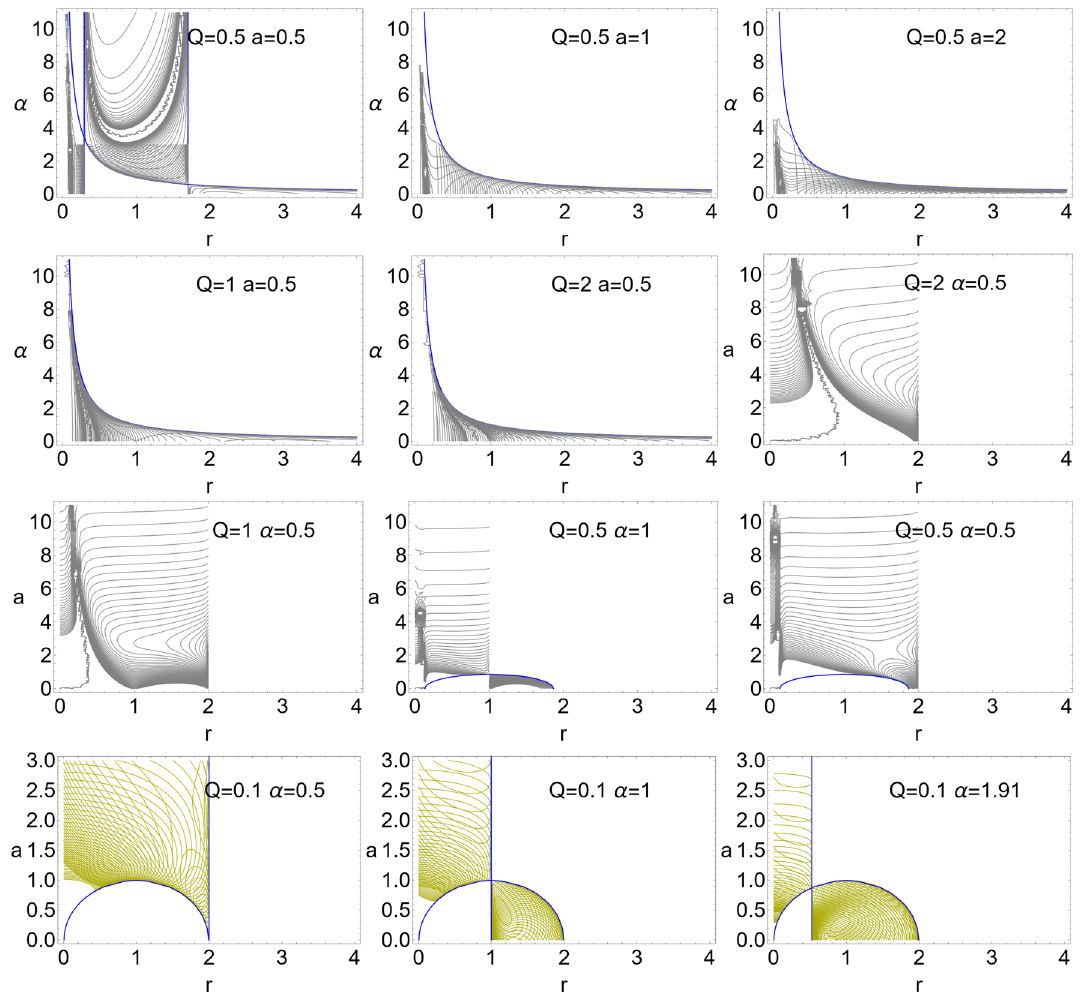
Fig. 9 Accelerating and spinning charged black holes of Eq. (26). Metric bundles on the equatorial plane are represented in the plane a − r for different charge Q and acceleration α values. Here M = 1 and a is the dimensionless BH spin parameter. Blue curves are the metric